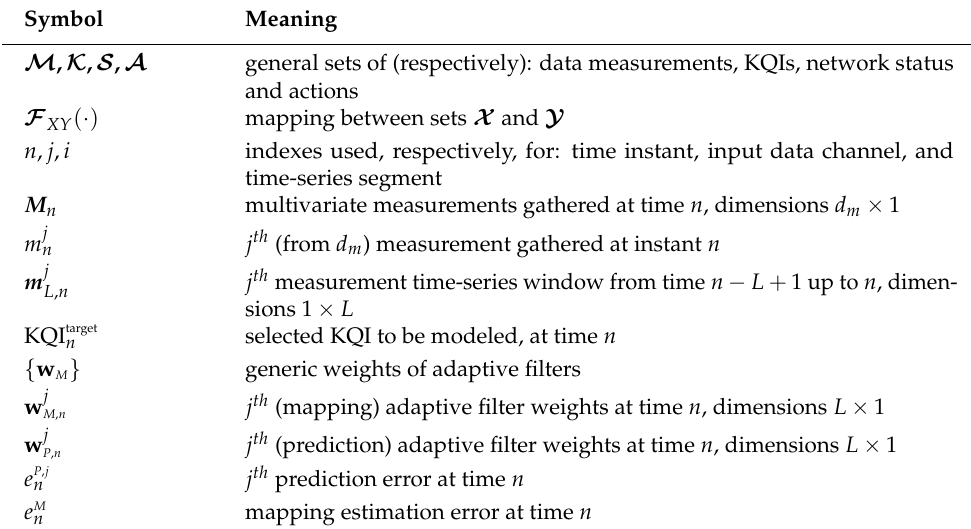
Table 1. Mathematical notation: main symbols with short